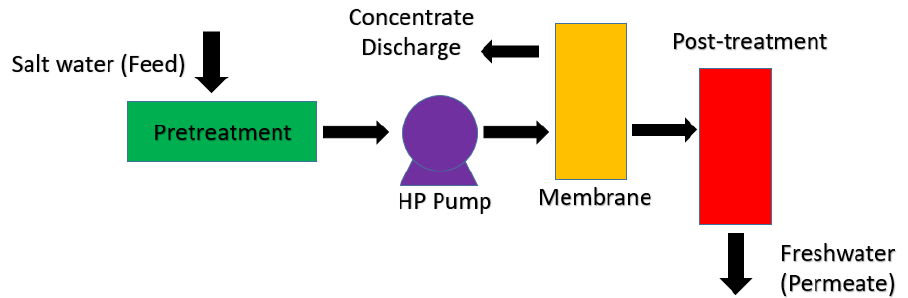
Figure 6. A conventional reverse osmosis Figure 8. A conventional reverse osmosis system.